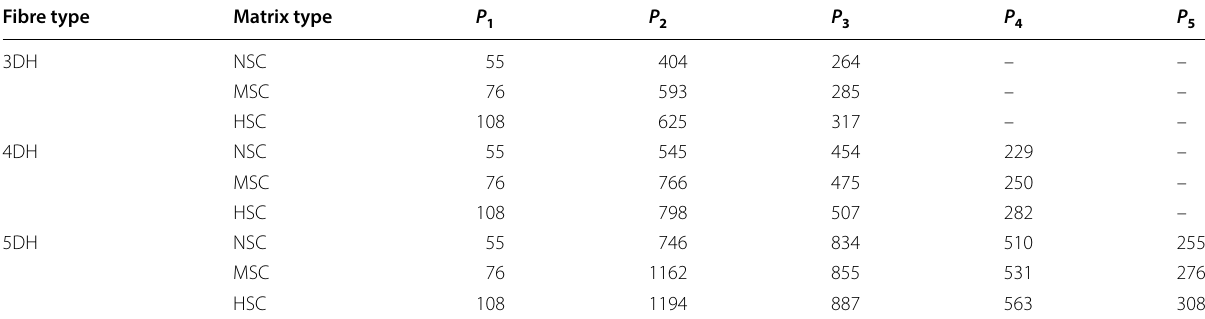
Table 5 The predicted pull-out forces for all hooked end fibres.